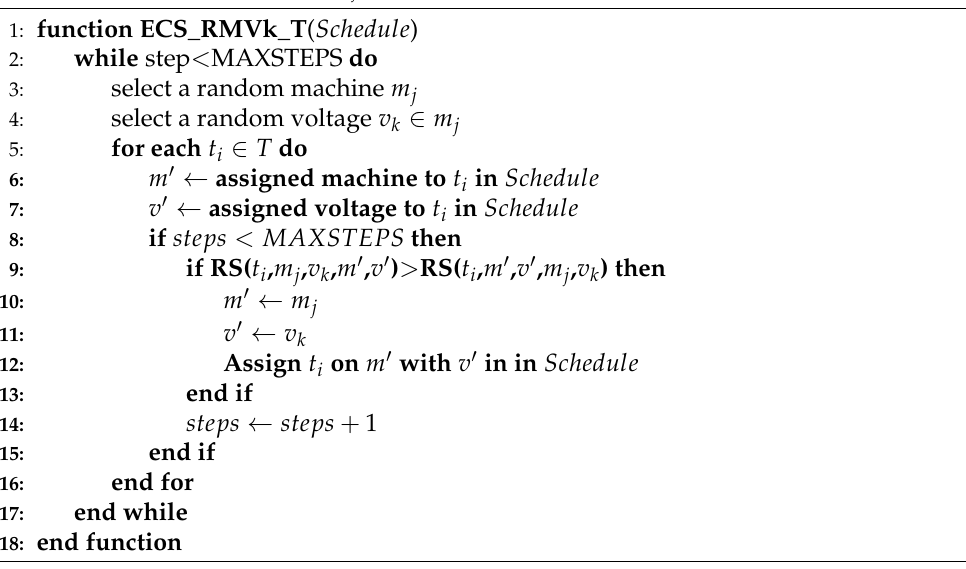
Algorithm 9 ECS + idle random m j / v k